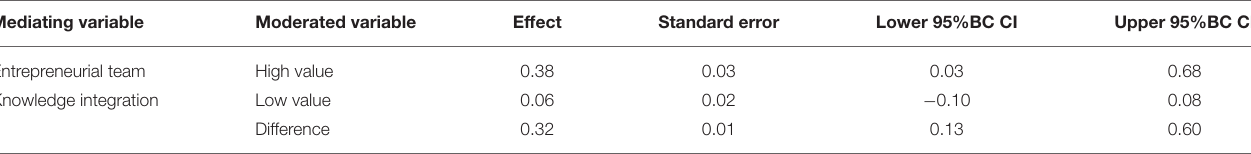
TABLE 4 | Moderated mediating